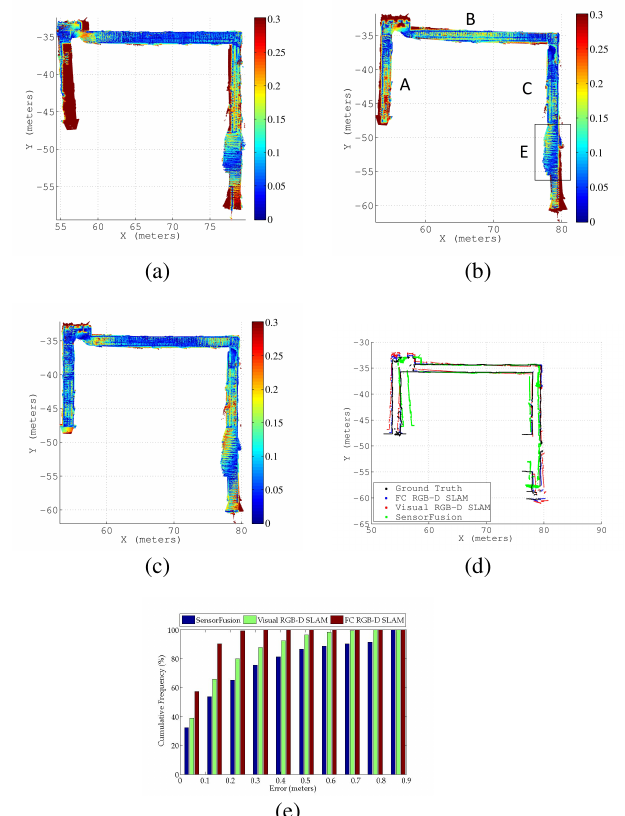
Figure 3. Spatial error distributions for a scanned corridor in vertical scanning mode: (a) model from SensorFusion; (b) model from visual RGB-D SLAM; (c) model from FC RGB-D SLAM; (d) Projected wall to the ground of four models (black is ground truth, blue is FC RGB-D SLAM, red is visual RGB-D SLAM, and green is SensorFusion); (e) Error histogram of the three systems To validate the proposed framework, three more data sets were captured using the same sensor with different data collection procedures. One set was obtained with the iPad horizontal, another set was obtained with the iPad horizontal and with a low frame rate (5 fps), and the third set was obtained with the iPad horizontal and facing the ground (uncaptured